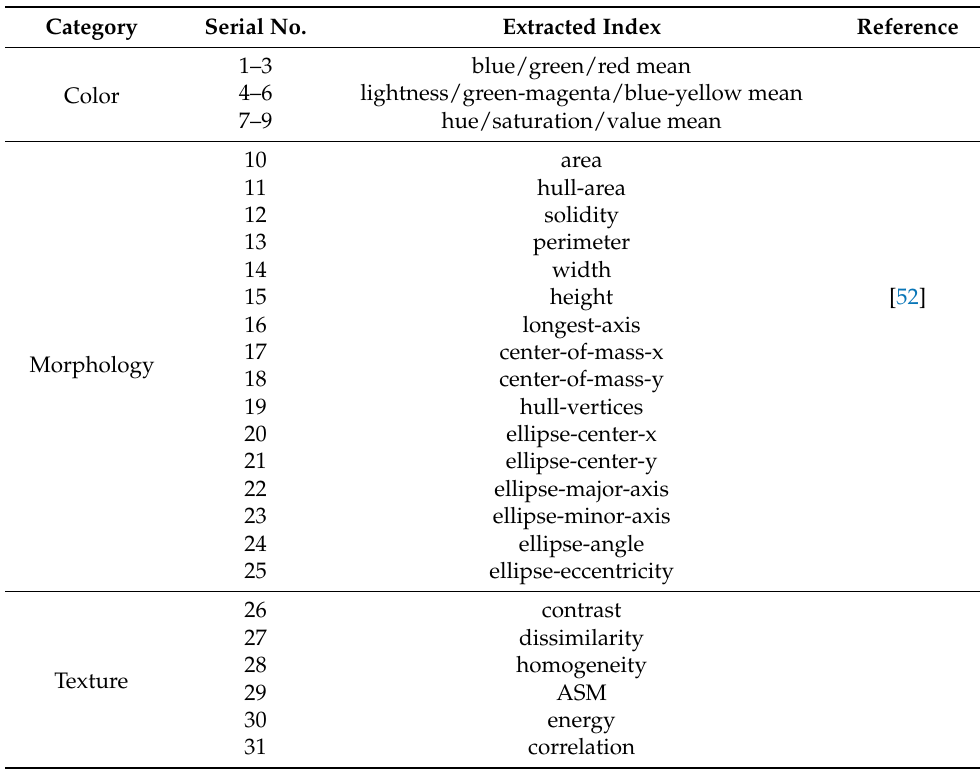
Figure 5. Color histogram ( A ) and pseudo-colored image ( B ) of leaf image. Thirty-one phenotypical parameters were extracted from each image and numbered 1 to 31 (Table 1), including 9 color parameters involved in 3 color spaces (RGB, LAB, and HSV), 16 morphological parameters based on contour tracking method, 6 netting charac- teristics parameters based on grey level co-occurrence matrix. All parameters contained means of four canopy leaves of plants. Table 1. List of phenotypic feature parameters.